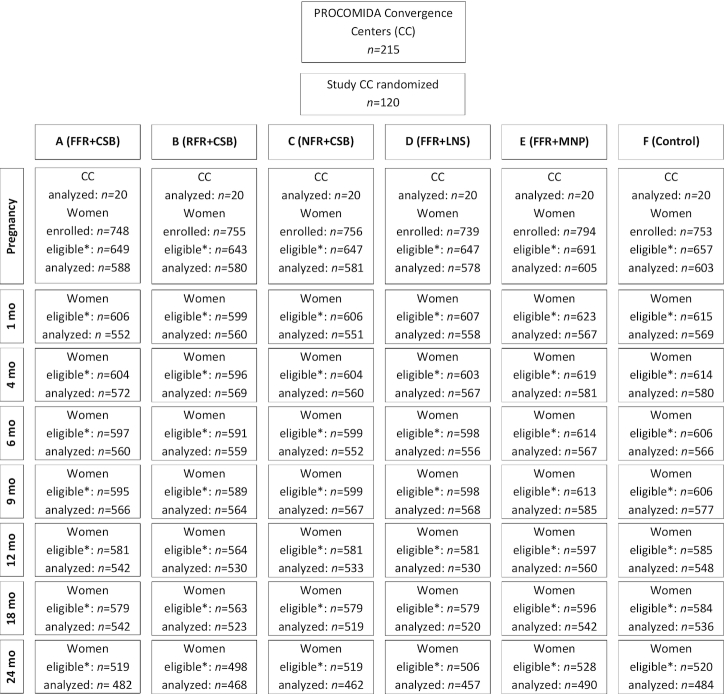
Trial profile. *Meets the eligibility criteria for the analyses presented in this article. CC, Convergence Center; CSB, corn–soy blend; FFR, full family ration; LNS, lipid-based nutrient supplement; MNP, micronutrient powder; NFR, no family ration; RFR, reduced family ration.